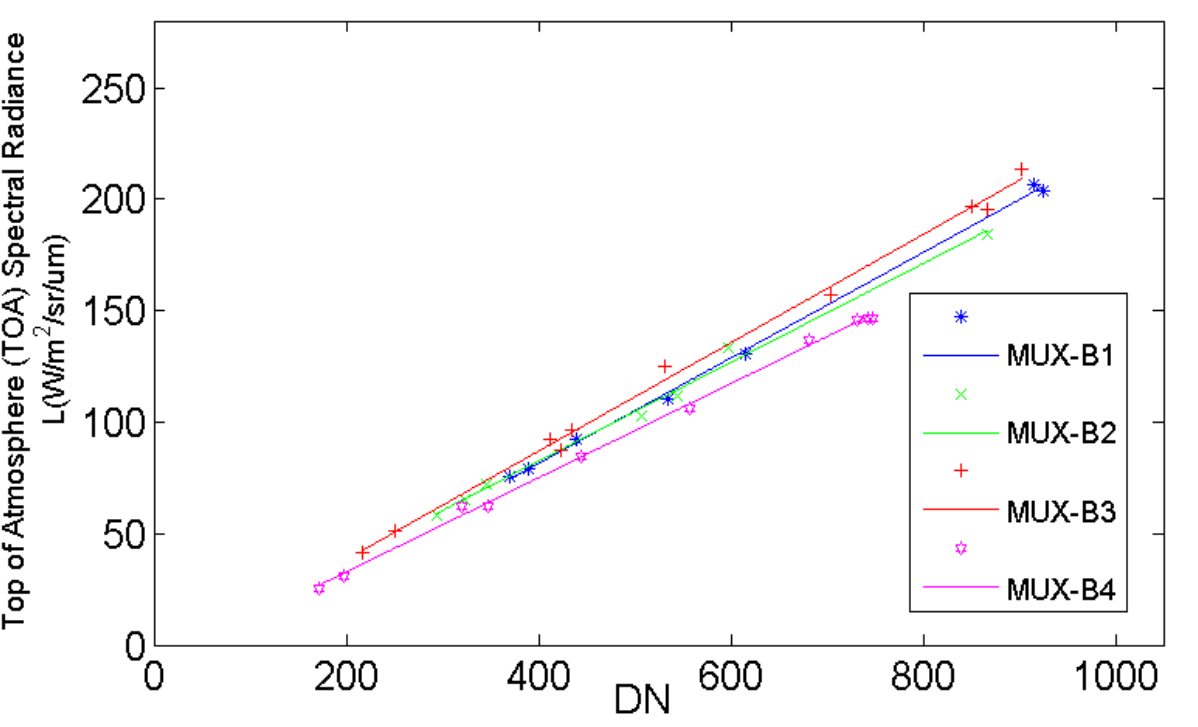
Figure 11. Calibration result of combining the permanent artificial targets and the radiometric calibration tarps (coefficient C).